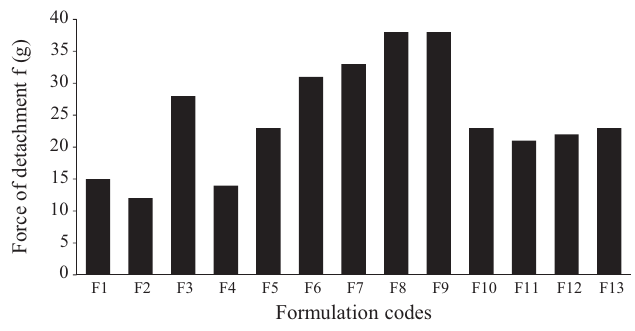
FIGURE 5 - Graphical representation of bioadhesive strengths required for the detachment of mucoadhesive tablets from a rabbit’s